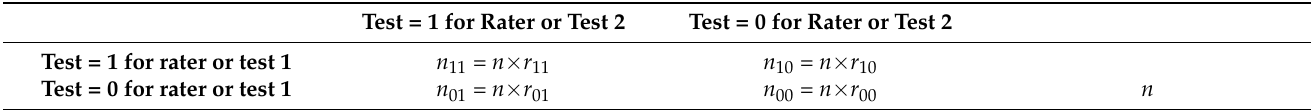
Table 1. Example of 2 × 2 table results based on a dichotomous scale obtained by two raters scoring n different animals for an item. Test = 1 for Rater or Test